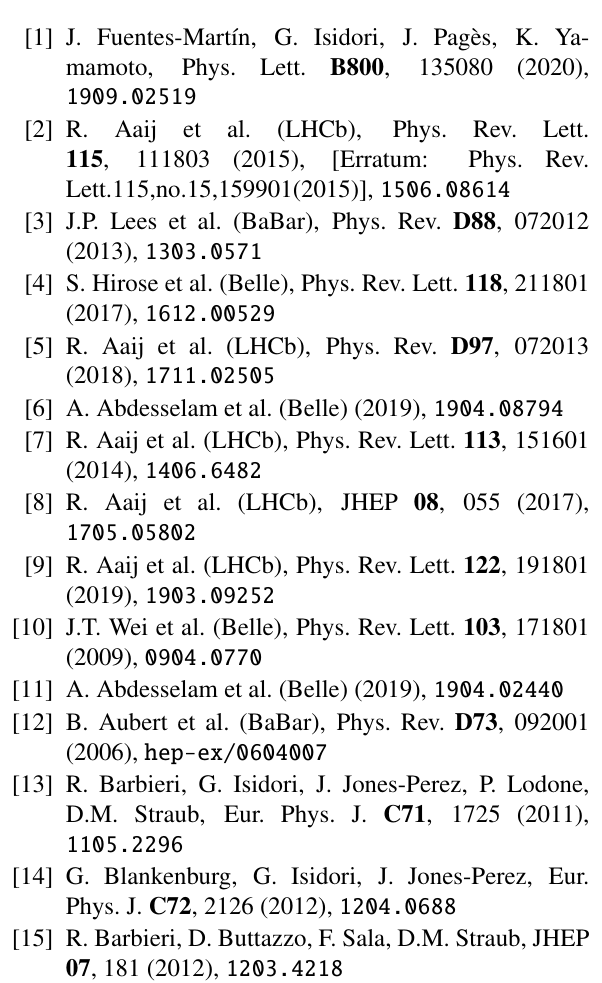
Figure 4. Predictions for B ( B s → µ ¯ µ ) as a function of ∆ R The purple and green bands correspond to two di ff erent bench- mark parameter values. The combination of ATLAS, CMS and LHCb measurements of B ( B s → µ ¯ µ ), and the combined R measurement are also